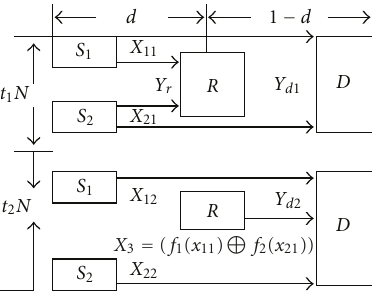
Figure 2: Cooperative protocol in MARC with one-block transmis- sion. In the t 1 slot, S 1 and S 2 broadcast x 11 and x 21 ; in the t 2 slot, R forwards the network-coded message x 3 , and S 1 and S 2 transmit x 12 and x 22